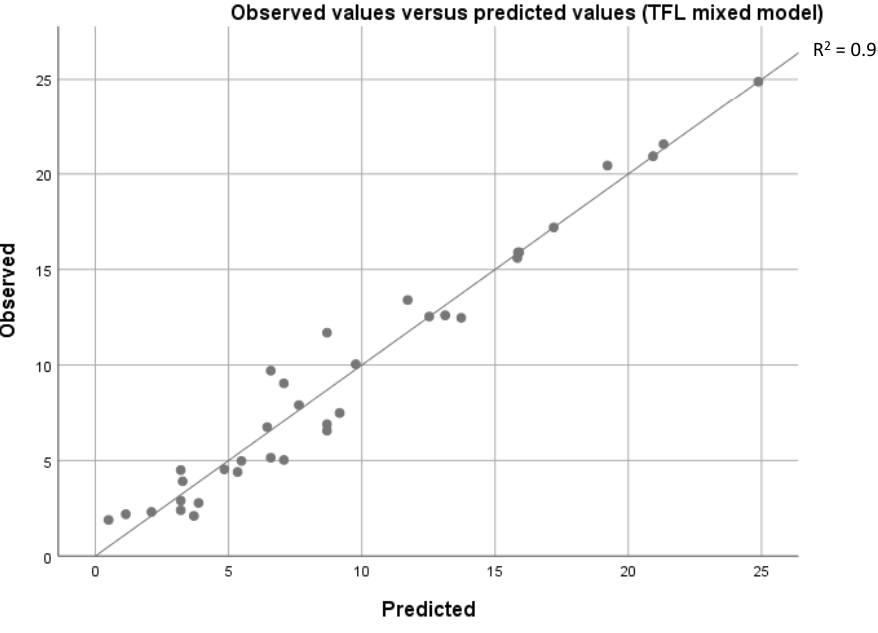
Figure 8. Plots of observed versus predicted values of TFL dynamics using the mixed model. TFL postfire reduction for our sampling plots (with the thermal pruning already incorporated) ranged from 38.14% (San Lorenzo A) to 92.18% (Viso B). This TFL